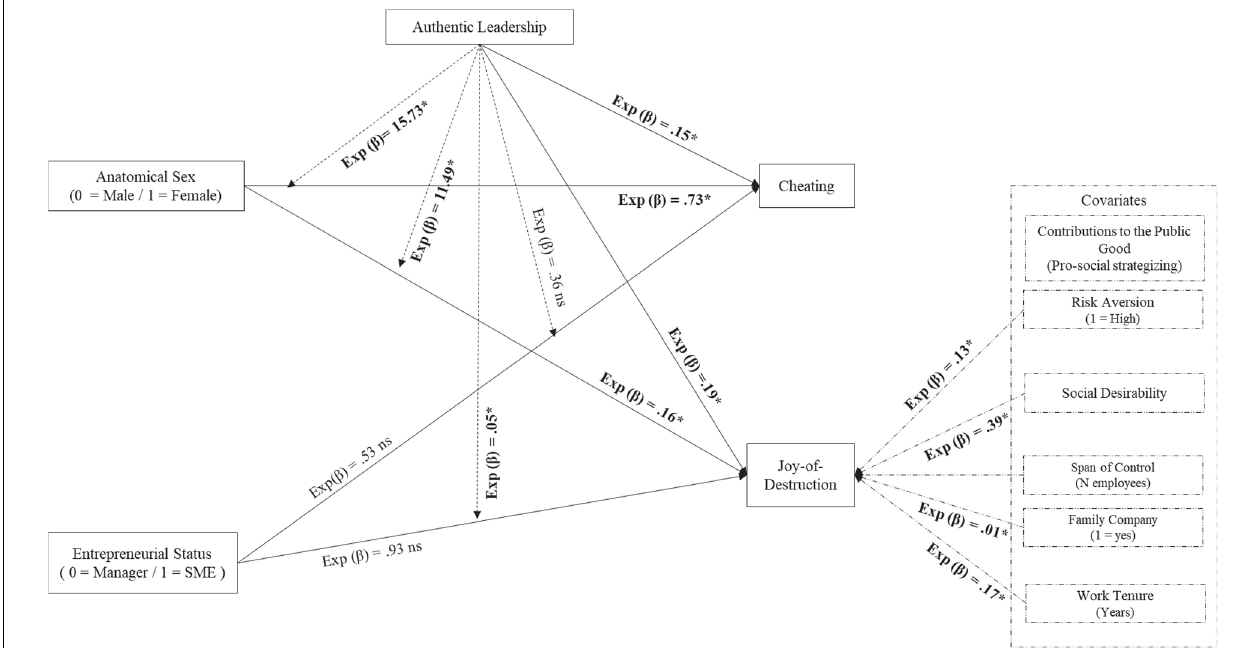
FIGURE 3 | Phase 2 – Main and interactive effects model (Logistic Regression). * p < 0.05; ns = non